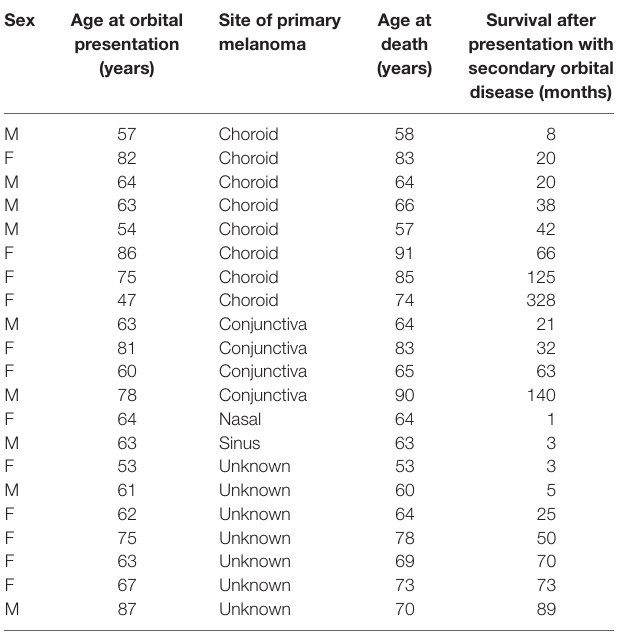
Patients classified as having “unknown” origin for their primary tumor had extensive systemic disease at presentation and poorly differentiated histology, this precluding a conclusive diagnosis of the primary site.